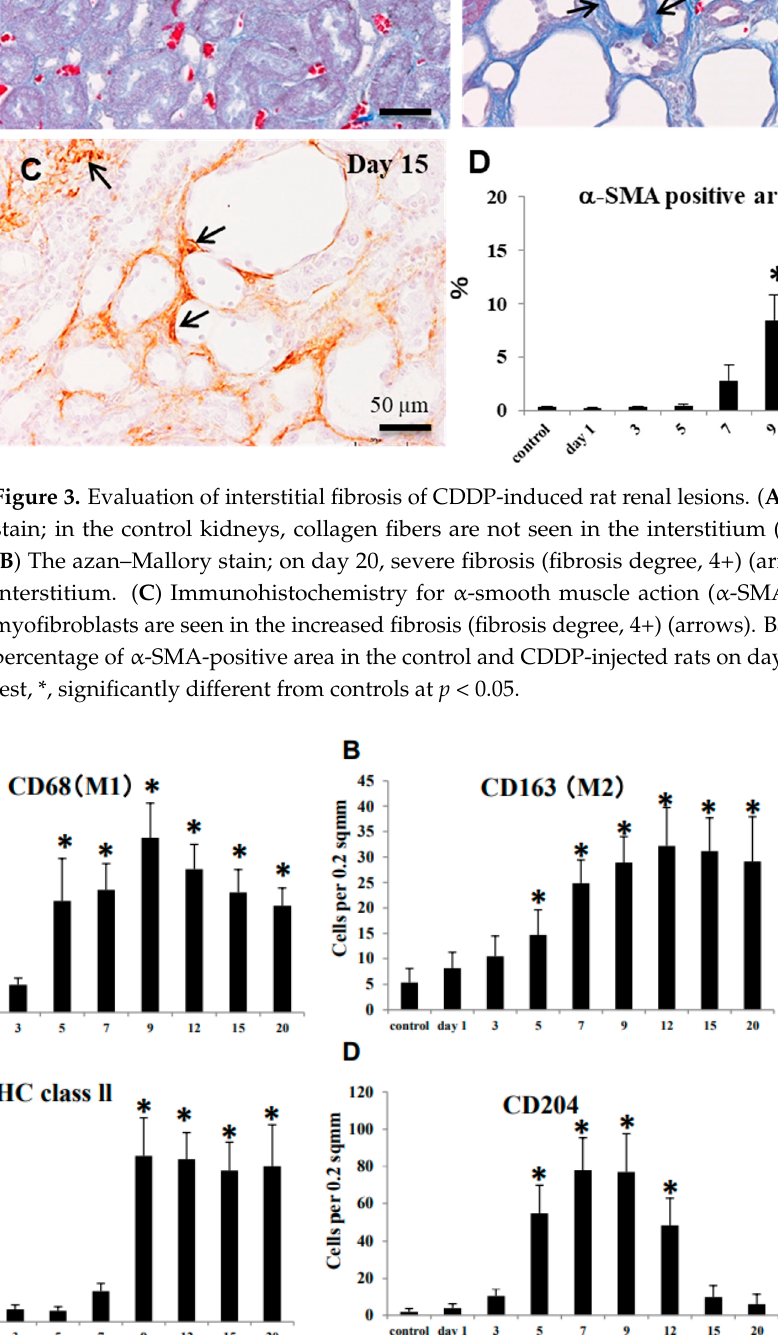
Figure 4. The number of macrophages reacting to CD68 ( A , for M1), CD163 ( B , for M2), MHC class II ( C ), and CD204 ( D ) in the control and CDDP-treated kidney on days 1–20. Note that the kinetics of these macrophages in comparison to controls differ from each other. Dunnett’s test, *, significantly different from controls at p < 0.05.